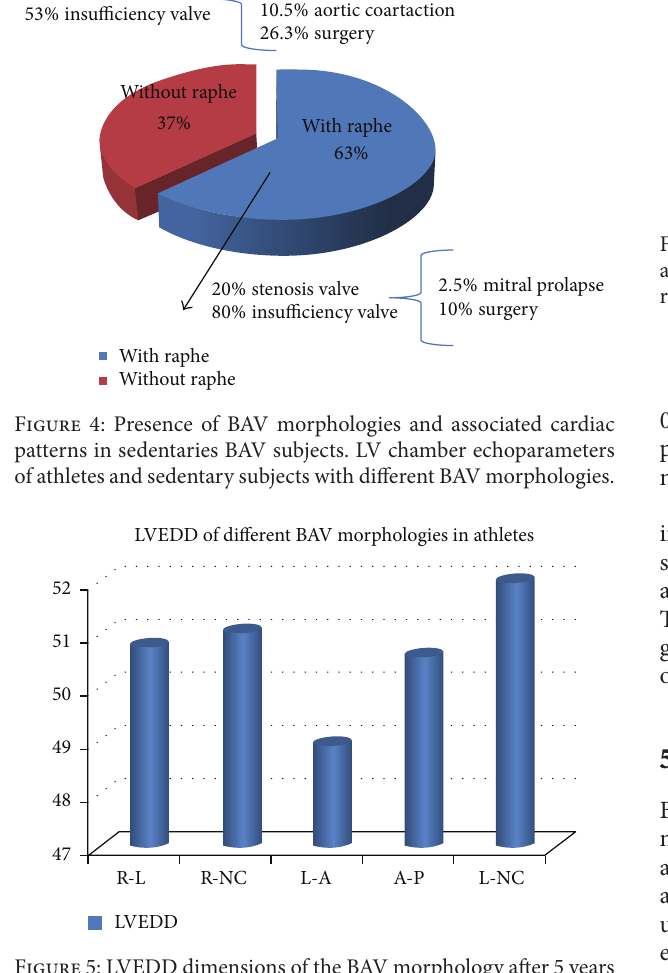
Figure 5: LVEDD dimensions of the BAV morphology after 5 years of followup. LVVD: left ventricle diastolic diameter; R-L: 50.80 ± 4.3 mm; R-NC: 51.04±4.0 mm; LA: 48.92±3.5 mm; AP: 50.69±3.3 ; L-NC: 52.5 ± 2.5 mm; P: NS for all.